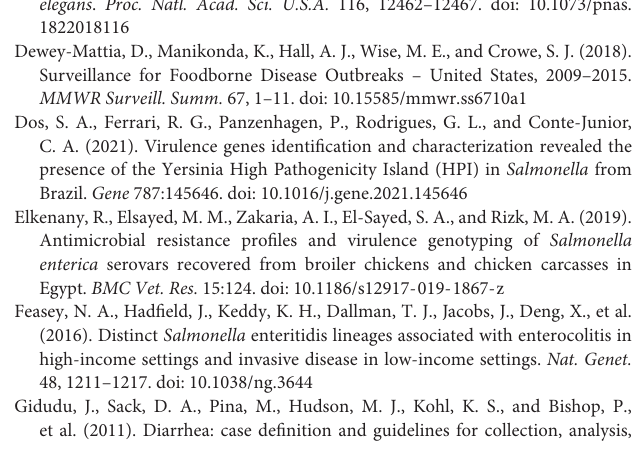
Supplementary Figure 1 | The vertical version of phylogenetic analysis based on 533 genomes including 20 genomes from the outbreak strains and 513 public genomes. The outbreak strains are light pink areas. Presence and absence of resistance genes were represented by dark red and light gray colors, respectively. Presence and absence of virulence genes were represented by dark blue and light gray colors,